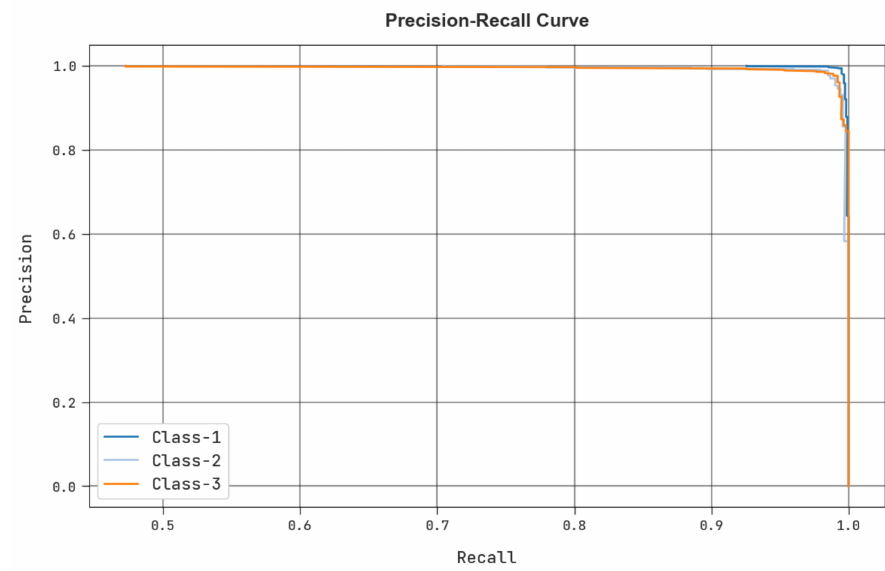
Figure 11. Precision recall analysis of MRFOTL-GCDC system.